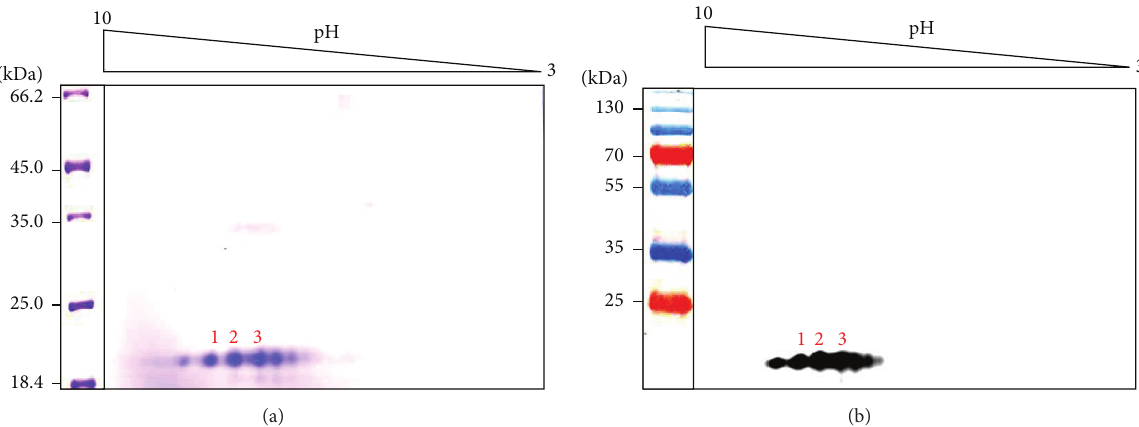
Figure 2: Two-dimensional gel electrophoresis of the purified r Lr IL-10. The purified r Lr IL-10 was resolved by isoelectric focusing using carrier ampholytes (pH 3–10, shown on top) followed by SDS-PAGE (12%). Panel (a) shows coomassie brilliant blue stained gel. The spots 1–3 were subjected to MALDI-TOF-MS (shown in Figures 1–3 in Supplementary Material). (b) Western blot analysis of identical gel shown in Panel (a) using anti-r Lr IL-10 antibodies. kDa indicates migration of the protein